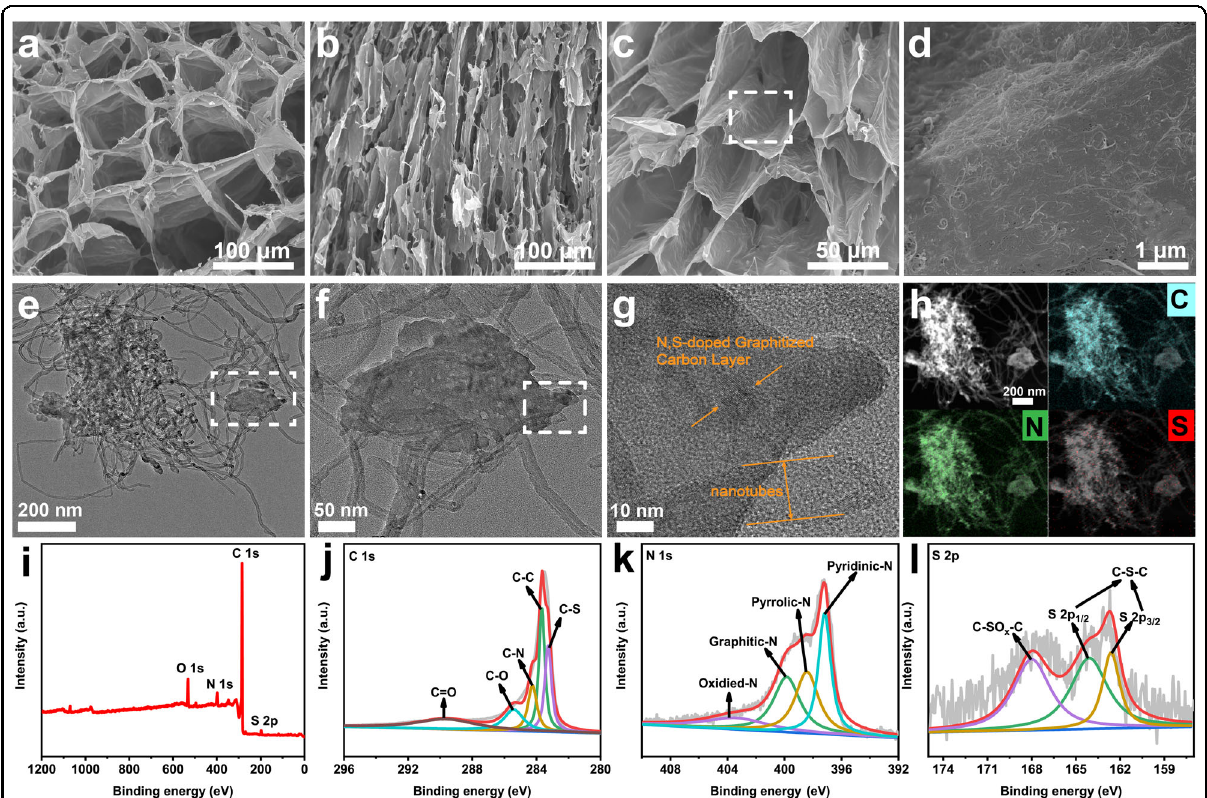
Fig. 2 Characterization of frameworks. a , b SEM images for different directions of N,S-doped frameworks. c , d Magni fi ed SEM images for N 1 S 1 @CF. e – g TEM images of